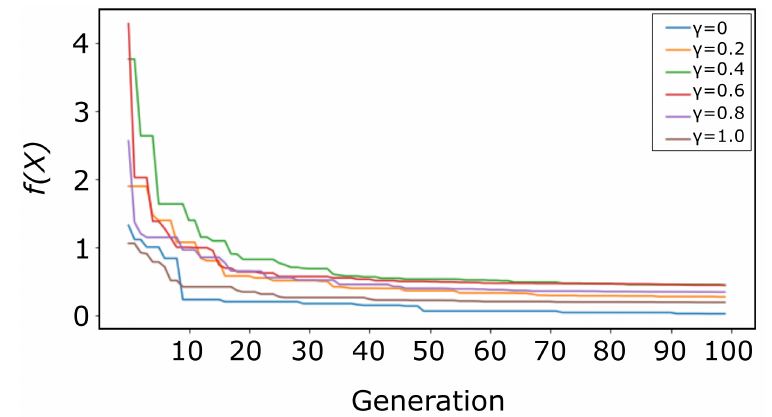
Figure 5. The convergence of the objective function f ( X ) with the DE